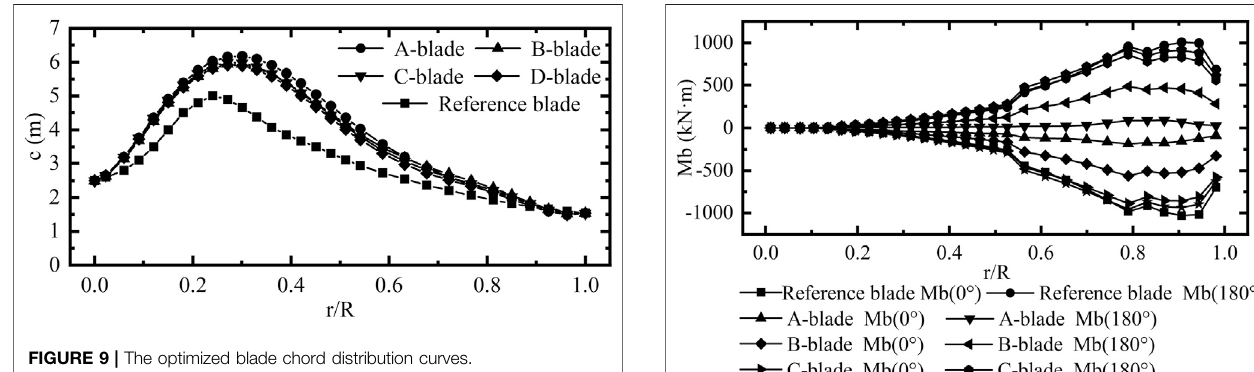
FIGURE 9 | The optimized blade chord distribution curves.